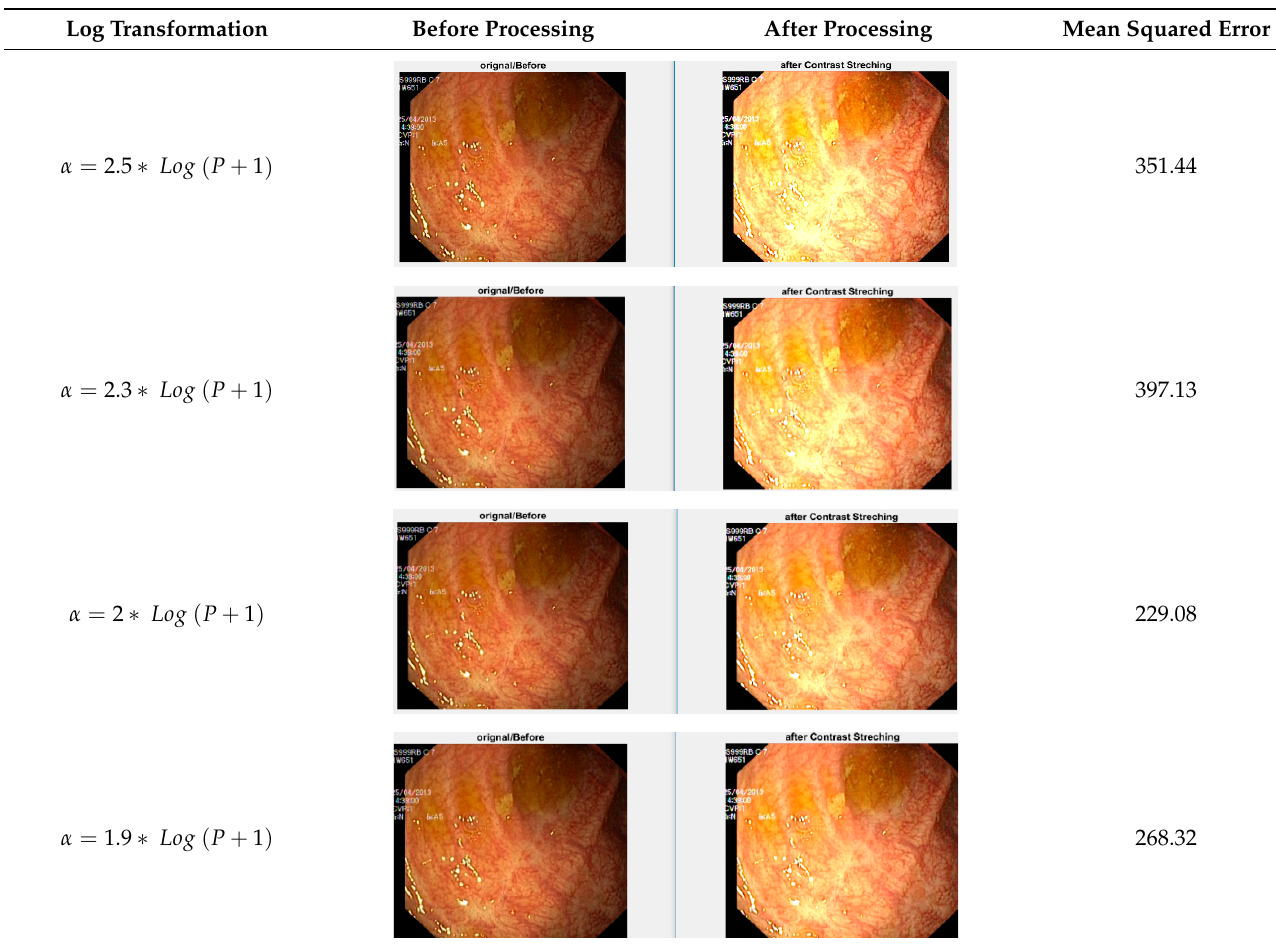
Figure 4. System architecture after applying log transformation. Table 2. Results after applying Log Transformation.